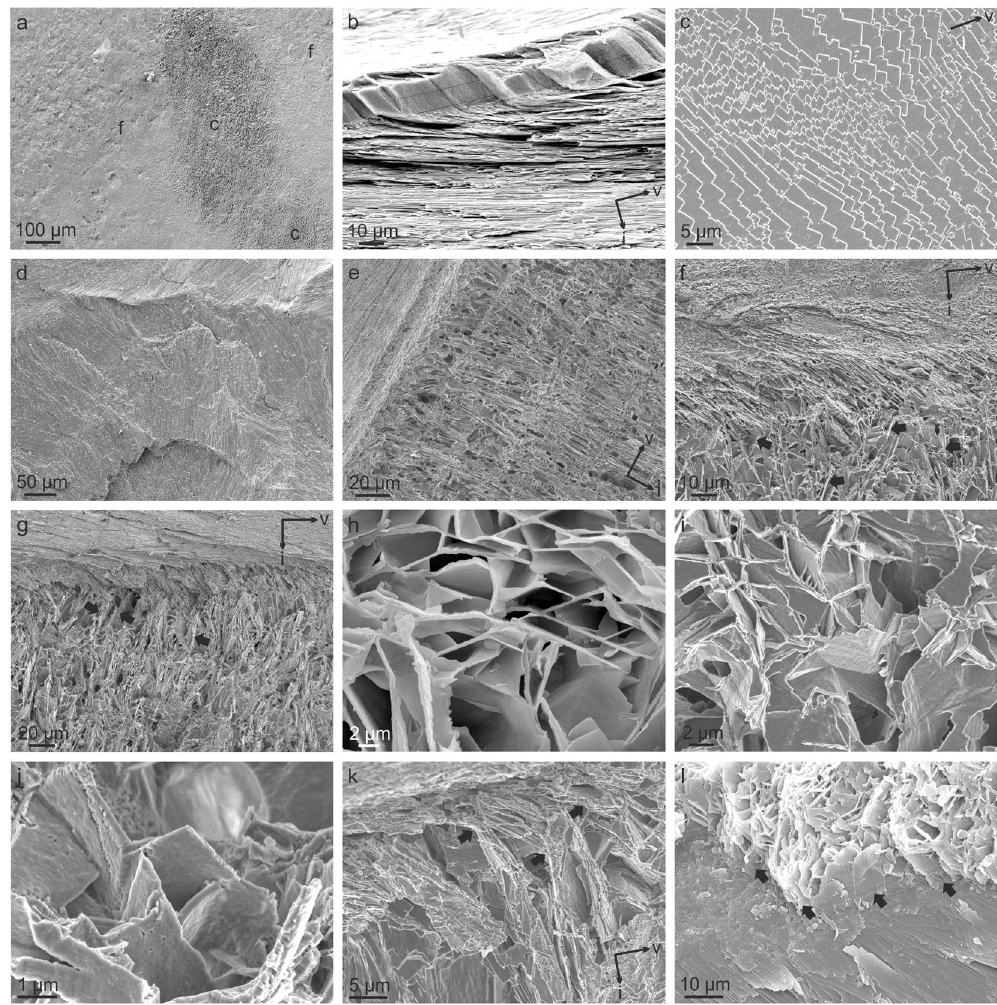
Figure 3. SEM views of microstructural details. ( a ) Chalk lens exposed on the inner surface of a left valve (f, foliated material; c, chalk). ( b ) Fractured right valve with outer prismatic and inner foliated layers. The inclination of laths with respect to the growth lines (some of them outlined with broken lines) is ~12°. ( c ) Foliated microstructure on the valve interior. Laths have varied orientations and their endings change from arrow pointed to straight. ( d ) Fracture subparallel to the valve surface showing bundles of laths in different orientations. ( e ) General view of the transition from the foliated microstructure (top left side) to the chalk. Blades are arranged roughly in perpendicular to growth lines. ( f ) Detail of the transition from the foliated microstructure to the chalk. At the transition, laths bend slightly towards the shell interior. Arrows point to some blades, apparently unrelated to laths of the foliated layer. ( g ) Detail of a transition similar to that in ( f ). In addition to bending, some laths deflect abruptly (arrows) at obtuse angles. ( h ) Detail of the chalk interior revealing consistent angular relationships between blades and leaflets. ( i ) Same as in ( h ) showing how the elements arrange polyhedrally. ( j ) Arrow point endings of some chalk elements. ( k ) Close up of the transition from the foliated microstructure to the chalk, showing abrupt changes in orientations of laths (arrows). ( l ) Surface view from the shell interior of the transition from the foliated microstructure to the chalk, showing sudden deflections of laths (arrows). All views are from M . angulata , except for ( b ) and ( c ) ( O . edulis ). Long arrows labelled ‘v’ and ‘i’ in ( b ), ( c ), ( e ), ( f ), ( g ) and ( k ) indicate the ventral and internal directions